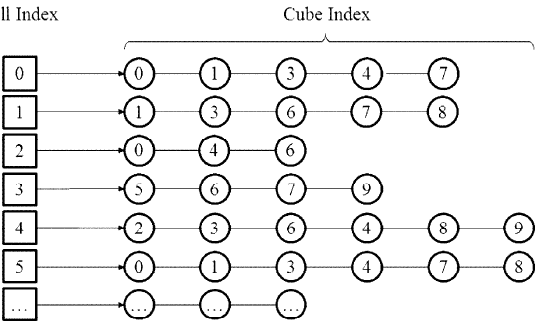
Figure 2. An illustration of the cell2cube list.